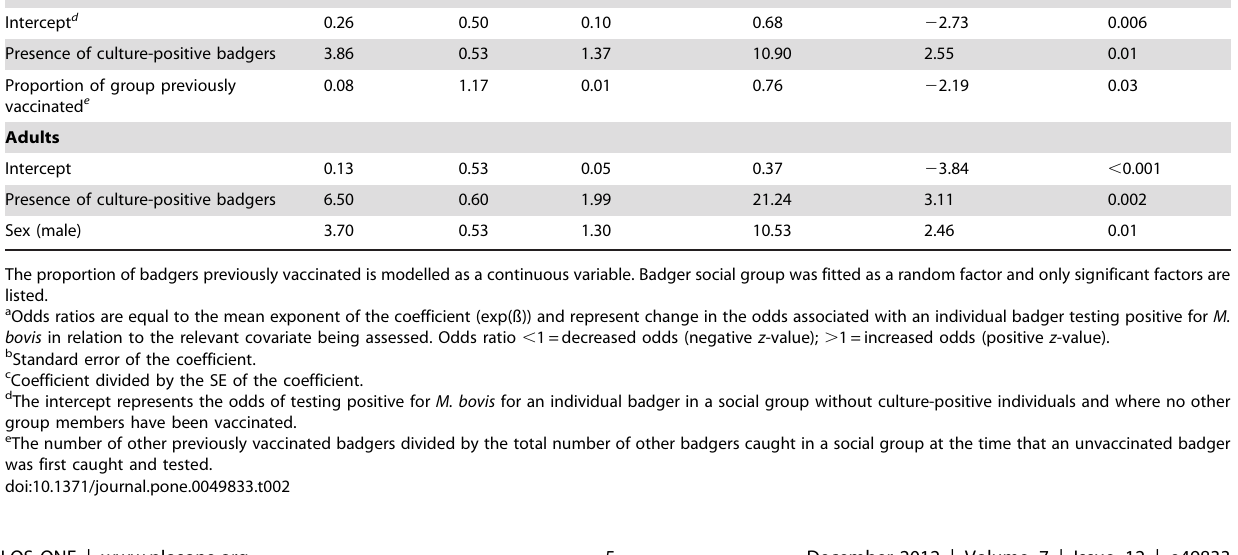
Outcome of the final event analysis model showing the individual risk of testing positive for each of the diagnostic tests and test combinations, SD and 95% confidence intervals associated with different explanatory factors. Only significant factors are listed. a Odds ratios are equivalent to the mean exponent of the coefficient (exp(ß)) and represent change in odds associated with an individual badger testing positive for M. bovis in relation to the relevant covariate being assessed. Odds ratio , 1=decreased odds (negative ß coef.); . 1=increased odds (positive ß coef.). b Standard deviation of the coefficient. c Triple test V is positive for one or more of IGRA (ESAT-6/CFP-10), Stat-Pak, or culture.